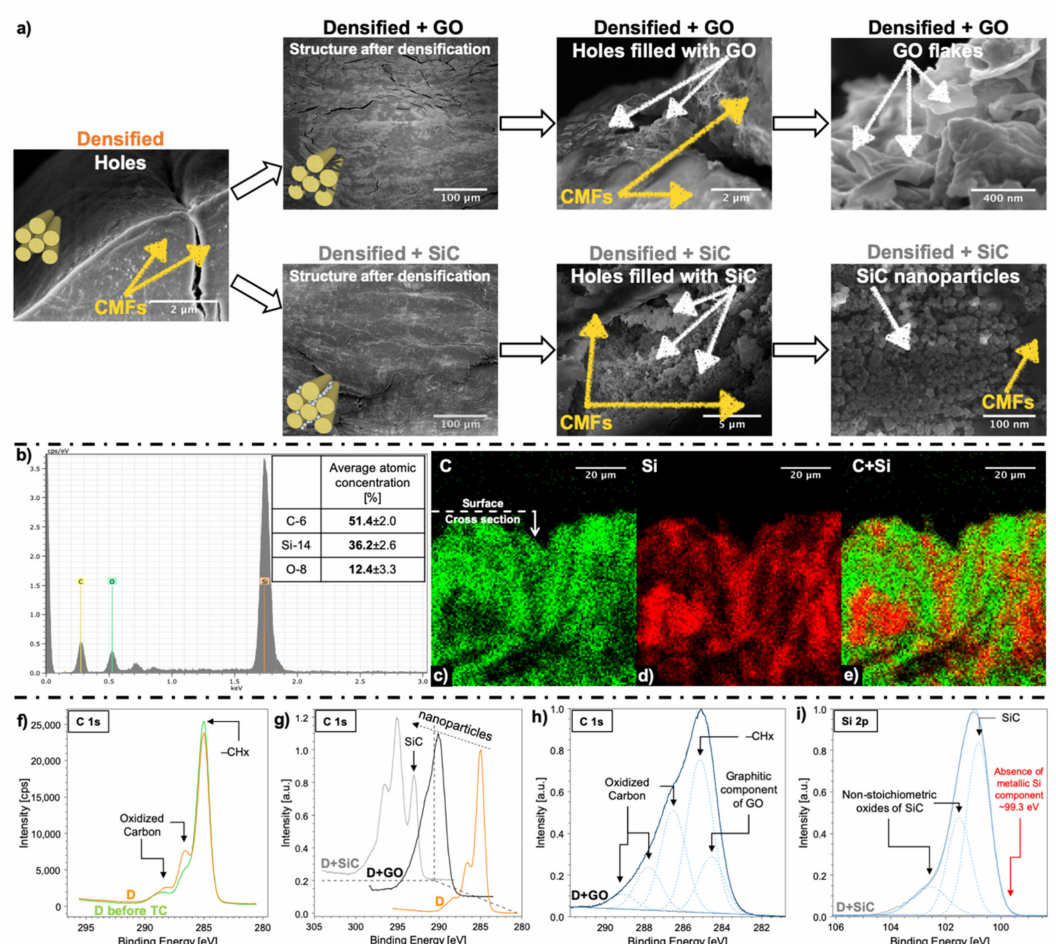
Figure 2. ( a ) SEM images of D, D + GO and D + SiC specimens. The second column displays the D + GO and D + SiC samples after nanoparticles intercalation and densification treatments: There is no evident morphological di ff erence between the two. The third and fourth columns show high magnification SEM images with details of the location of SiC nanoparticles and GO flakes at the interface of cellulose microfibrils (CMFs). GO, SiC, and CMFs are highlighted with arrows. ( b ) EDX spectrum performed at 10 keV. The table reports the average quantitative elemental analysis of carbon (C), silicon (Si), oxygen (O) from three di ff erent wide scans sampled next to the surface in SiC-rich regions. Maps of the atomic percentage of the cross-section of D + SiC specimens: ( c ) C, ( d ) Si, ( e ) C + Si. XPS analysis of the ( f ) thermo-compression treatment on lignin etched reed, ( g ) nanoparticles intercalation on densified reed; ( h ) GO flakes, and ( i ) SiC nanoparticles intercalation in the densified reed. EDX analysis was carried out to investigate the distribution of silicon in the D + SiC